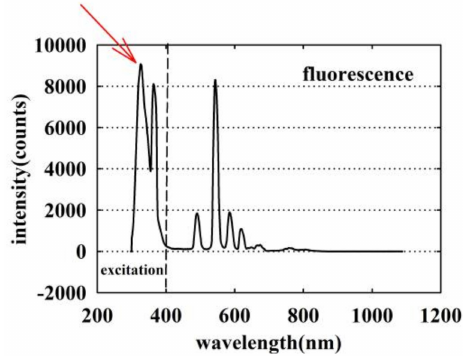
Figure 3. The experimentally measured optical spectrum of the La 2 O 2 S:Tb scintillator based